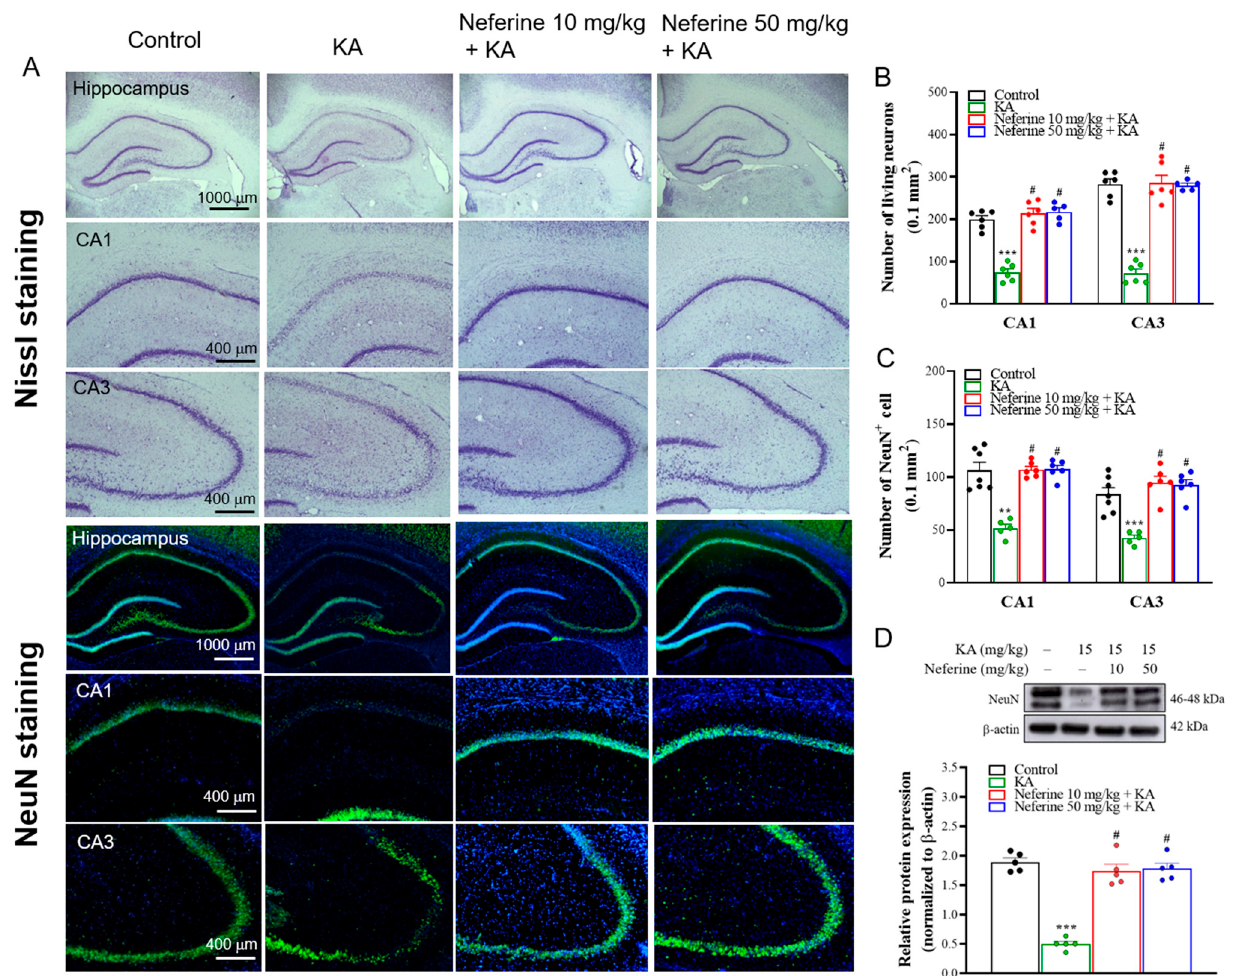
Figure 2. Results of Nissl and NeuN staining in the rat hippocampus. ( A ) Representative images and ( B , C ) quantitative data for the number of Nissl- or NeuN-positive hippocampal neurons ( n = 5–7 rats/group). Neferine increased the numbers of Nissl- or NeuN-positive hippocampal neurons in the CA1 and CA3 areas (one-way ANOVA). ( D ) Representative Western blot images in the dif- ferent groups and densitometric values for NeuN were normalized to β -actin levels ( n = 5 rats/group). Statistical results of immunoblot analysis show that neferine increased the band intensities of NeuN (one-way ANOVA). ** p < 0.01. *** p < 0.05 vs. control group. # p < 0.05 vs. KA-treated group.